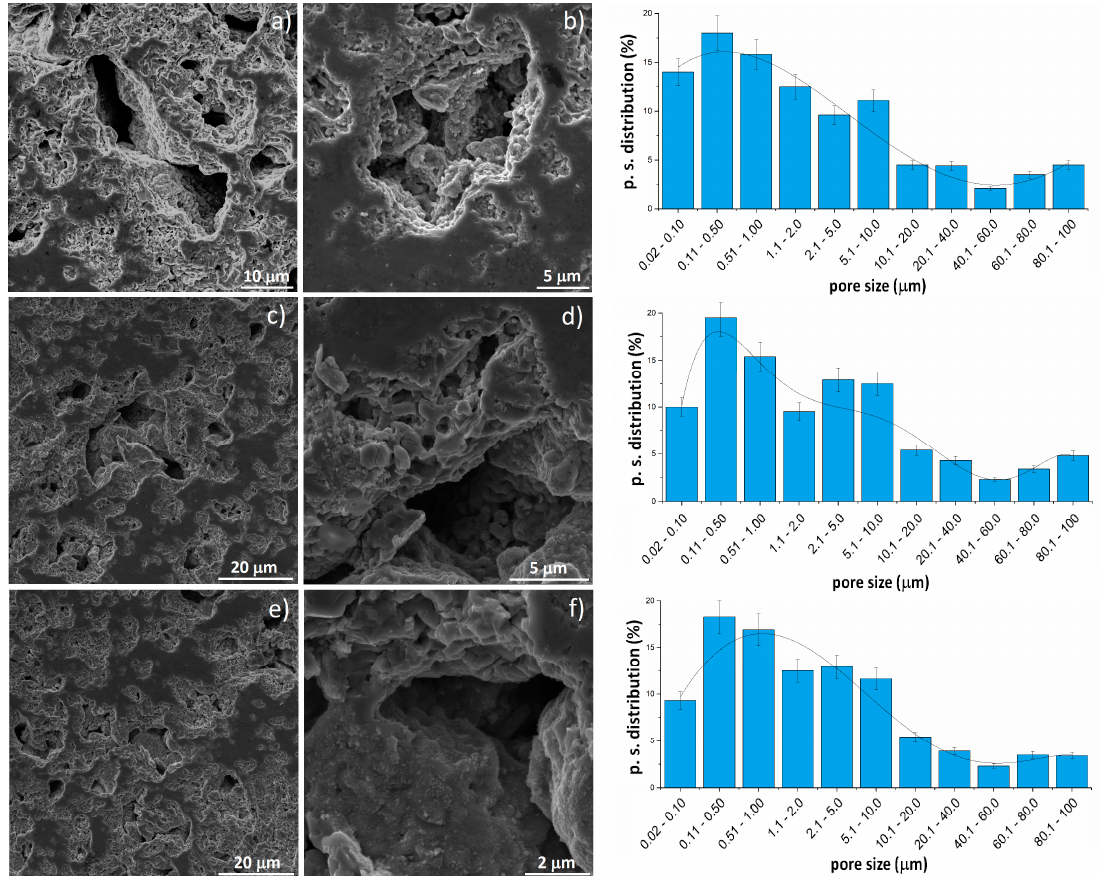
Figure 4. SEM image of: ( a,b ) Ti-30Ta ( + initial 30 Mg), ( c,d ) Ti-30Ta ( + initial 40 Mg), ( e,f ) Ti-30Ta ( + initial 50 Mg) metallic foams.